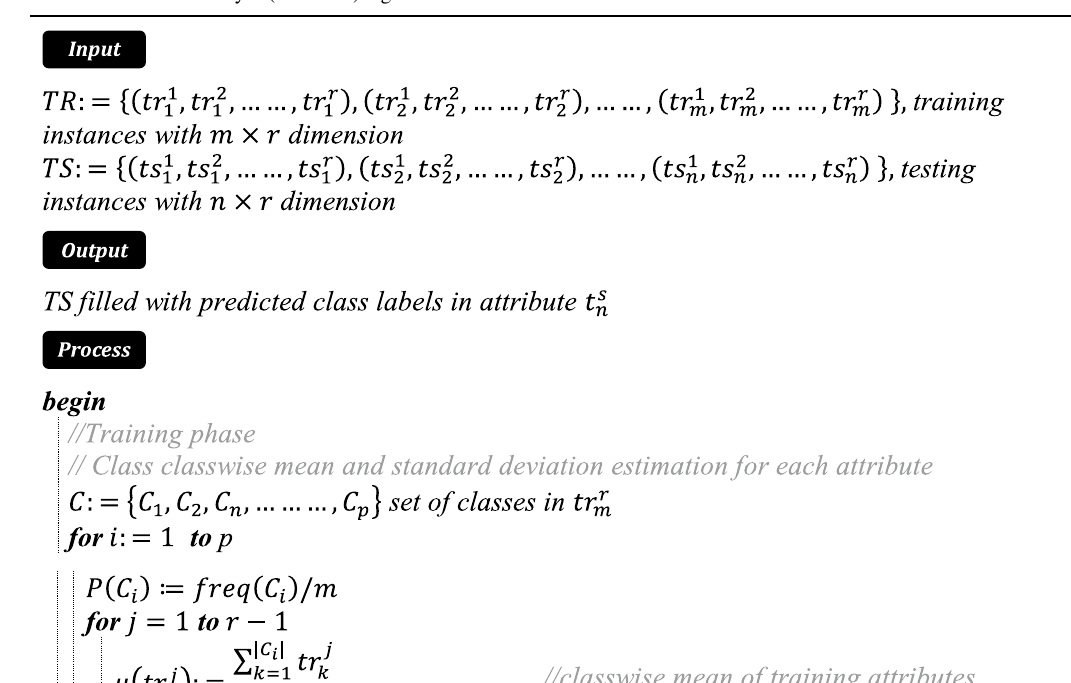
Table 10 Pseudocode of Naïve Bayes (Gaussian)